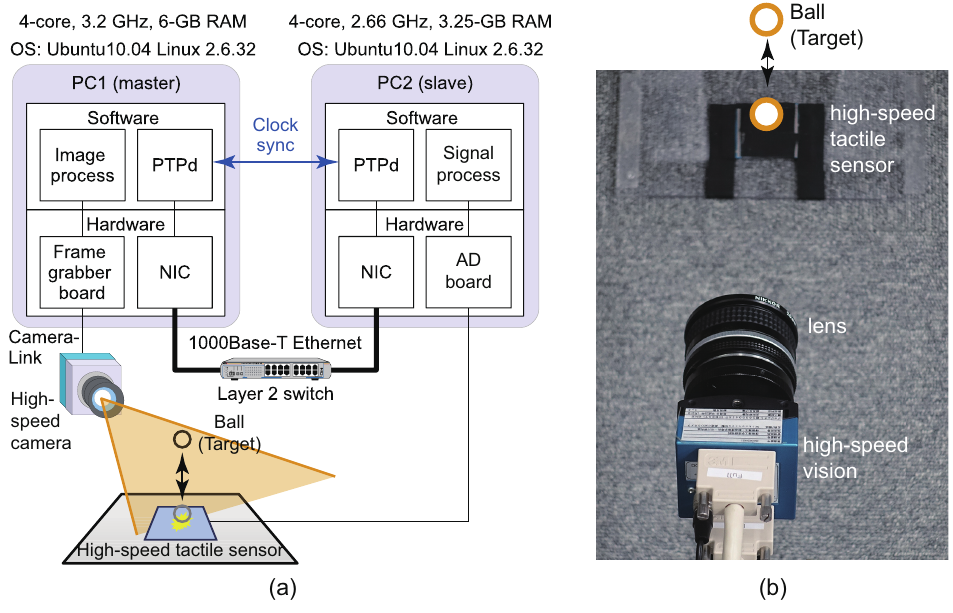
Figure 3. Overview of experimental system setup: ( a ) shows system structure and ( b ) shows experimental environment. Adapted from